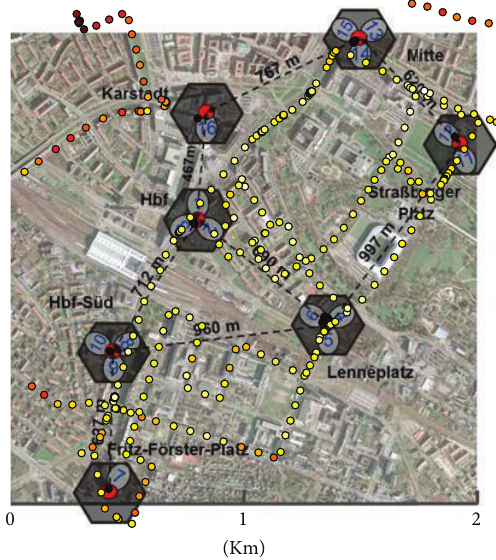
Figure 13: Field trial setup and measurement locations (colored dots) for the first field trial. The color indicates the SNR to the strongest base station for a downtilt of 6 ∘ .